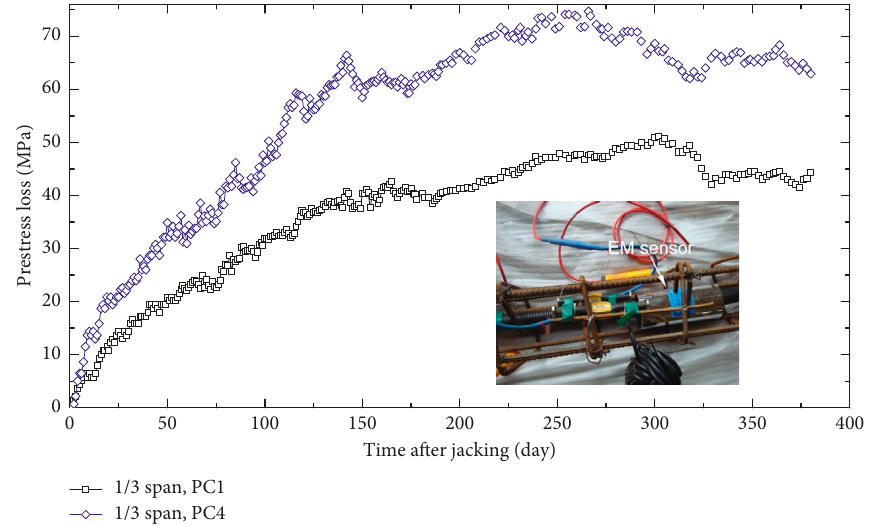
Figure 8: Long-term prestress losses of beams PC1 and PC4.